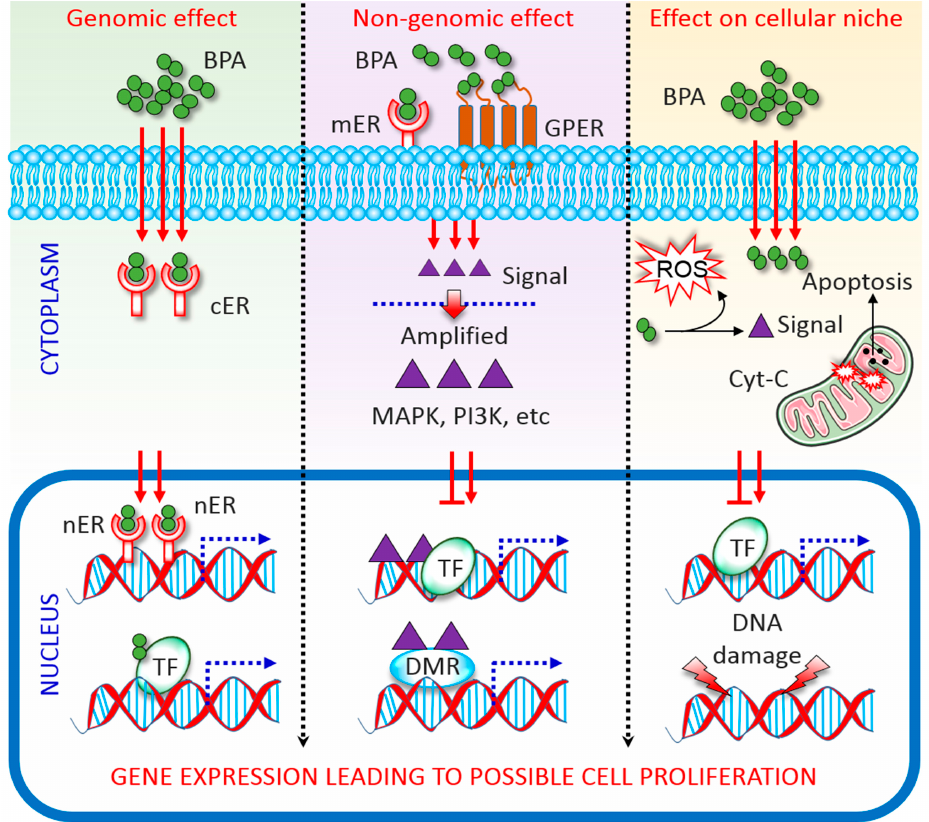
Figure 1. Mechanisms of Bisphenol A (BPA) activity. Genomic, non-genomic, and direct effects exerted by BPA are depicted. See the main text for details. BPA, bisphenol A; DMR, differentially methylated regions; cER, cytoplasmic oestrogen receptor; Cyt-C, cytochrome c; GPCR, G protein-coupled receptor; MAPK, mitogen-activated protein kinase; mER, membrane-bound oestrogen receptor; nER, nuclear oestrogen receptor; PI3K, phosphatidylinositol 3-kinase; ROS, reactive oxygen species; TF, transcription factor.